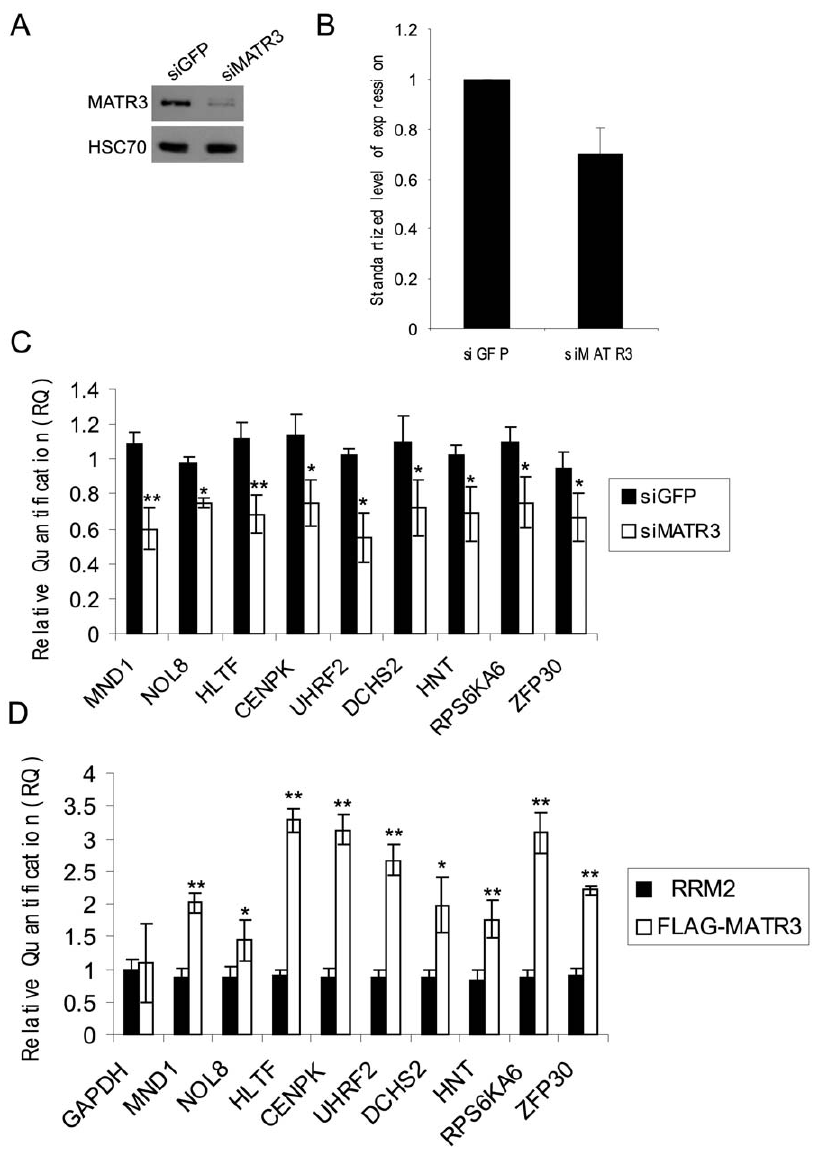
Figure 4. MATR3 affects the transcript level of mRNAs that bind to it. ( A ) Knockdown of MATR3 in U2OS cells: western blotting analysis of total cellular extracts 96 hr after transfection with siGFP or siMATR3. ( B ) Effect of MATR3 depletion on the expression of 77 human genes. Expression profiles were recorded in U2OS cells knocked-down for MATR3 and in control cells transfected with siGFP, using Affymetrix Human Gene 1.0 ST arrays. Responding genes in the datasets (defined as showing at least 1.7 fold-change in expression level) underwent clustering analysis using the CLICK algorithm [35]. A cluster containing 77 genes was obtained containing genes whose expression level was reduced in MATR3 knocked-down cells ( Table S1 ). The plot represents average expression levels of these genes normalized against their average level of expression in the siGFP samples. ( C ) Validation of results obtained using microarray analysis. RNA was extracted from U2OS cells knocked-down for MATR3 and from control cells transfected with siGFP was reverse transcribed, and qPCR was carried out. Shown is the relative quantification (RQ) as fold-change compared to the siGFP cells. Two endogenous control transcripts were used: GAPDH and hTBP. The plot represents the mean of three independent experiments and error bars represent SD (*P # 0.05, **P # 0.01, t test). ( D ) Binding of mRNAs to MATR3. The extent of binding of mRNAs to wild type vs. D RRM2 served as a measure of mRNA binding to the protein. RNA was extracted from the MATR3 immune complexes shown in Figs. 3A and Phe-tRNA was added. qPCR was carried out on reverse transcription products and the Relative Quantification (RQ) is shown as fold-change of signal compared to D RRM2 minus the background of the empty vector. The plot represents the mean of three independent experiments and error bars represent SD (*P # 0.05, **P # 0.01, t test). used for the microarray experiment and subsequent experiments RNAi were carried out using OnTarget Plus SMARTpool against RNA duplexes of 19 nucleotides (AGACTTCCATG- MATR3, which was obtained from Dharmacon (Lafayette, CO). GACTCTTA) targeting human MATR3 mRNA were designed, U2OS cells were grown to 20%–50% confluency and transfected and subsequently synthesized by Dharmacon (Lafayette, CO) with with siRNA using the DharmaFECT 1 reagent (Lafayette, CO). the OnTarget Plus modifications. The above oligonucleotide was